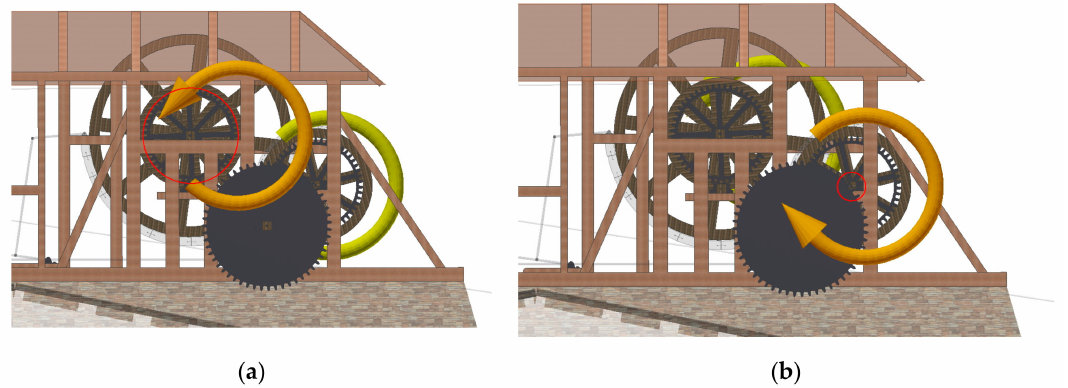
Figure 11. ( a ) Torques applied on the AA shaft and ( b ) on the EE